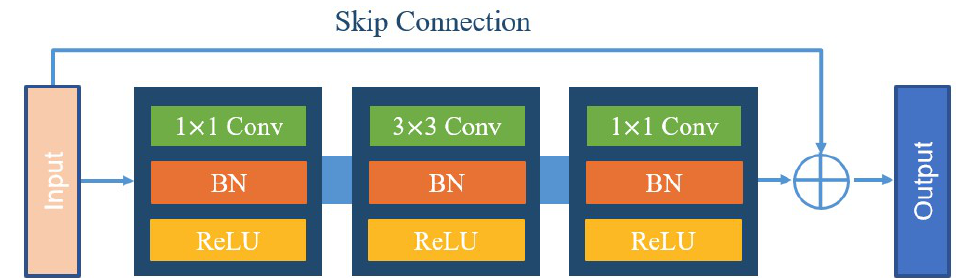
Figure 2. The structure of the residual block.